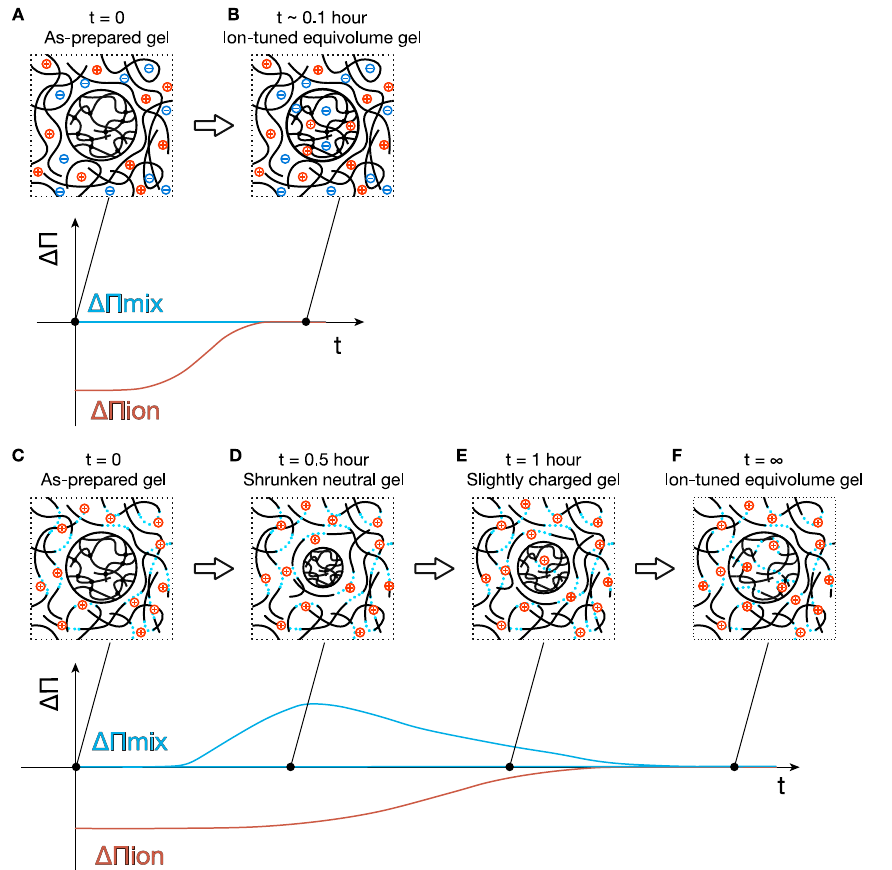
Figure 3. Illustration of the post-ion-tuning process. ( A ) An N0S0 gel is immersed in an N0S500 solution, and ( B ) in a short time (~0.1 h), the gel reaches equilibrium before the gel could take a volume-change response because of the quick ion diffusion. ( C ) An N0S0 gel is immersed in an N50S0 solution. ( D ) The gel shrinks, and the acrylic acid groups in the gel network do not dissociate yet because of the slow dissociation process of PAA. ( E ) The acrylic acid groups in the gel are slightly charged, and the gel swells a bit. ( F ) Finally, the neutralization degree and the salt concentration in the gel become the same as the reservoir, and the gel returns to its initial volume. The graph below each conceptual image of gels indicates the difference of the mixing and ionic osmotic pressure between the gel and reservoir